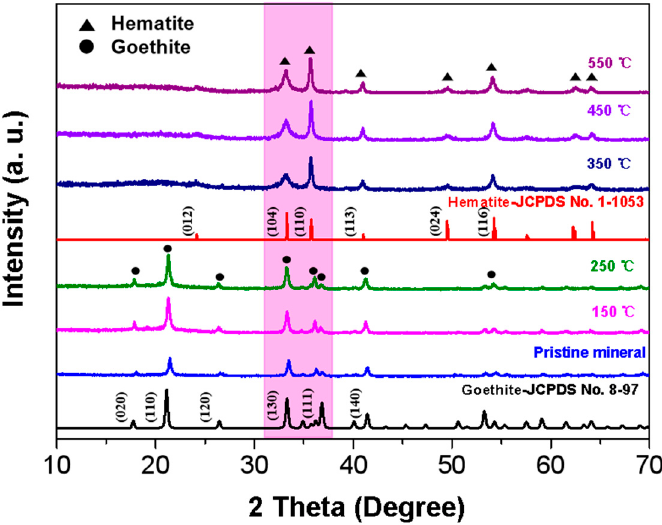
Figure 1. XRD patterns of goethite and calcined goethite at different